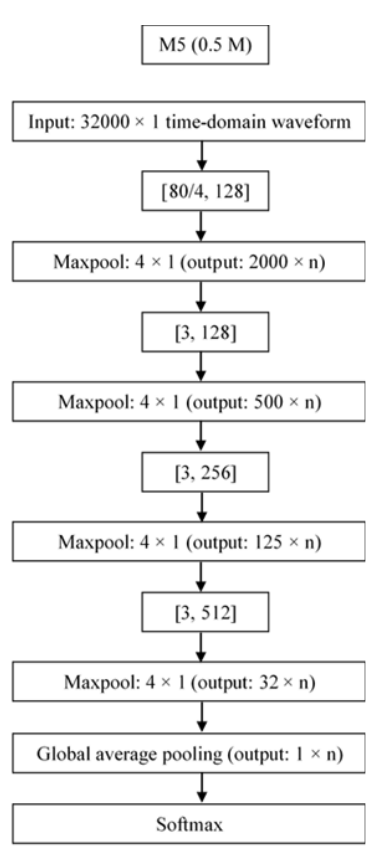
Figure 3. Representation of M5 audio architecture.